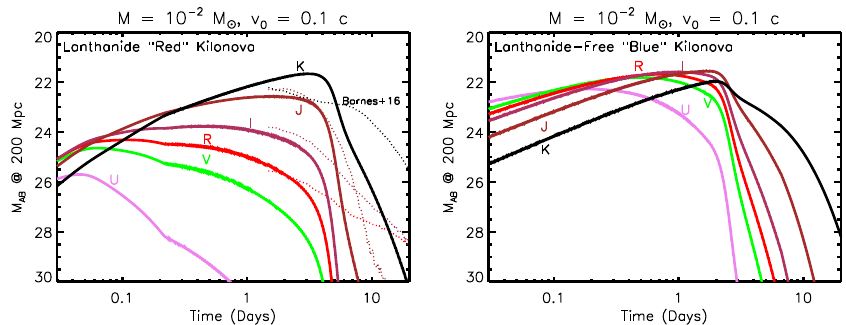
Fig. 5 Kilonova light curves in AB magnitudes for a source at 200 Mpc, calculated using the toy model presented in Sect. 4, assuming a total ejecta mass M = 10 − 2 and minimum velocity v 0 = 0 . 1 c. The top panel shows a standard “ red ” kilonova, corresponding to very neutron-rich ejecta with Lanthanide elements, while the bottom panel shows a “ blue ” kilonova produced by ejecta without Lanthanides. Shown for comparison in the red kilonova case with dashed lines are models from Barnes et al. (2016) for v = 0 . 1 c and M = 10 − 2 M (cid:4) .Dependingontheviewingangleoftheobserver,both red and blue emissioncomponents may be present in a single merger, if they originate from different locations in the ejecta (Fig.